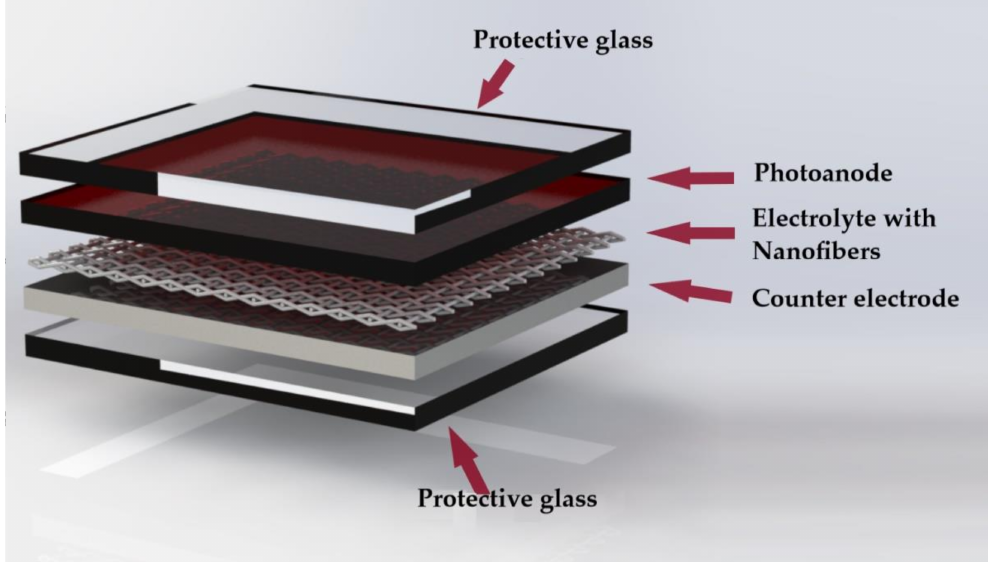
Figure 5. Electrolyte with electrospun nanofibers in a